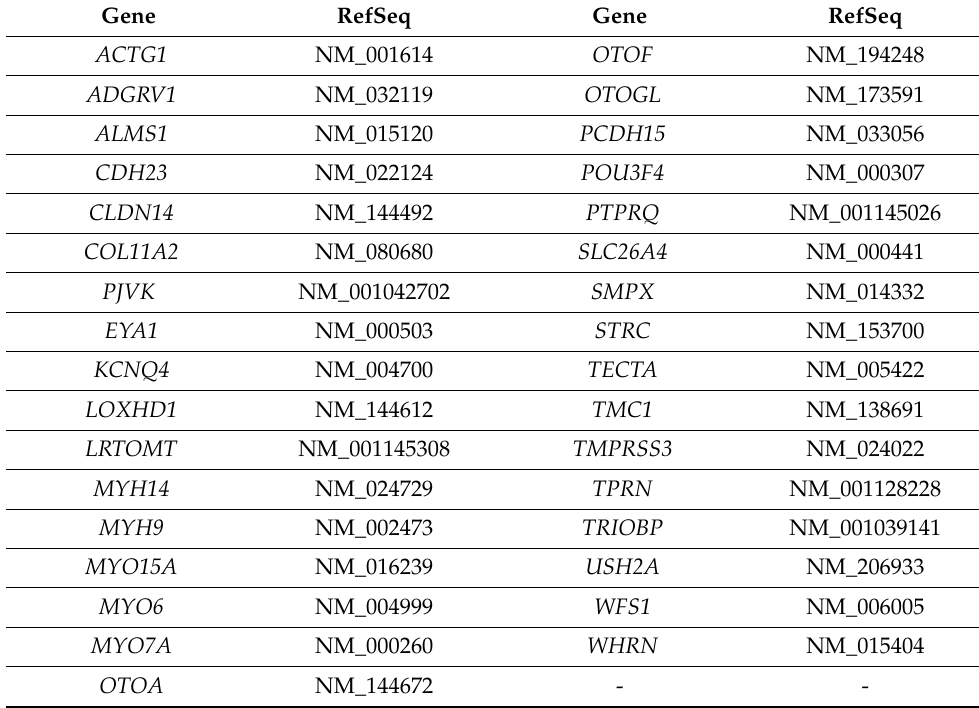
Table 3. The genes included in the MPS panel and their reference